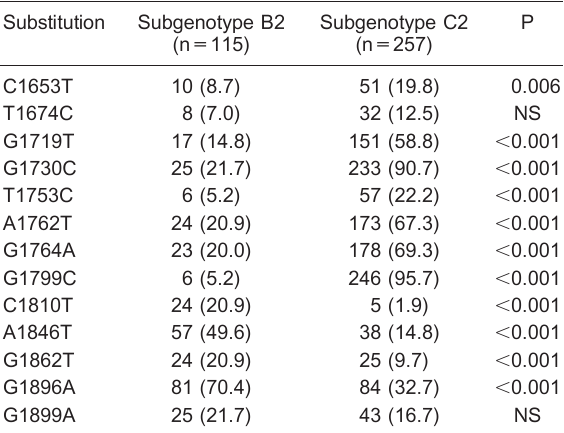
Table 5. Determination of subgenotype-associated mutations in the enhII/BCP/precore regions of